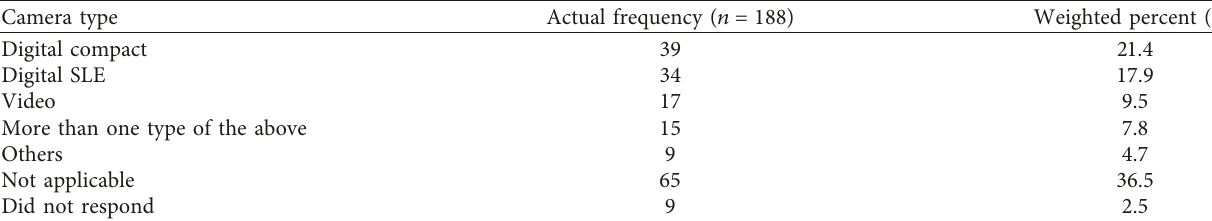
Table 3: Types of camera used.